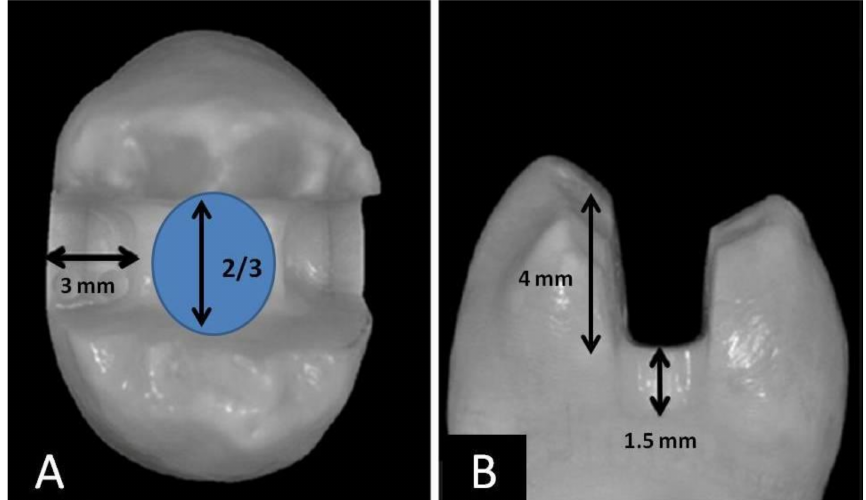
Figure 2. ( A,B ) Representation of the cavity preparation used in this work. In blue, endodontic access